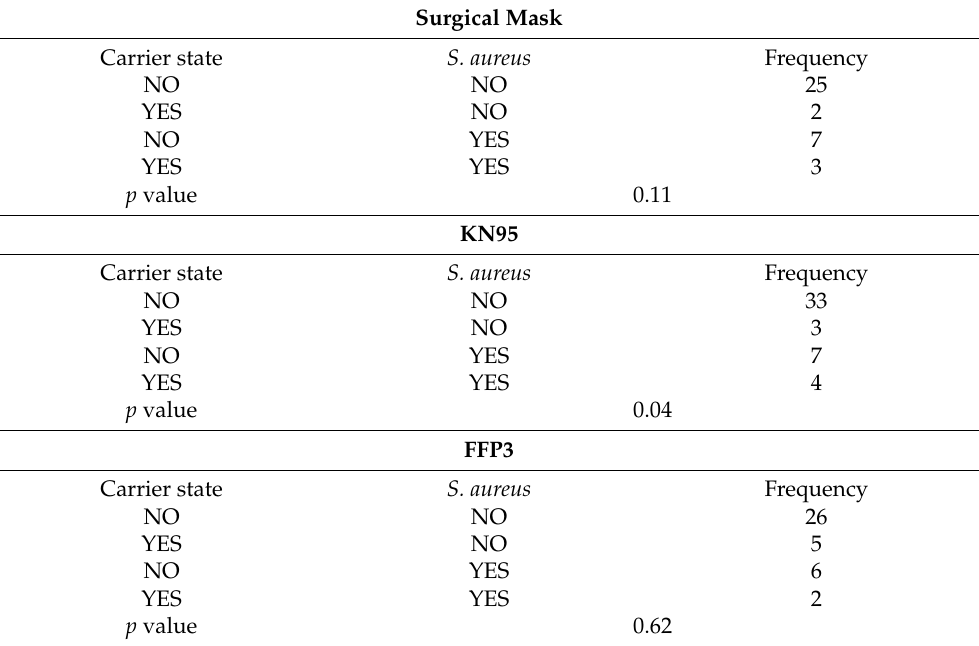
Table 4. The presence of S. aureus on the surface of surgical, KN95, and FFP3 masks using Fisher’s exact test. p value < 0.05 was considered statistically